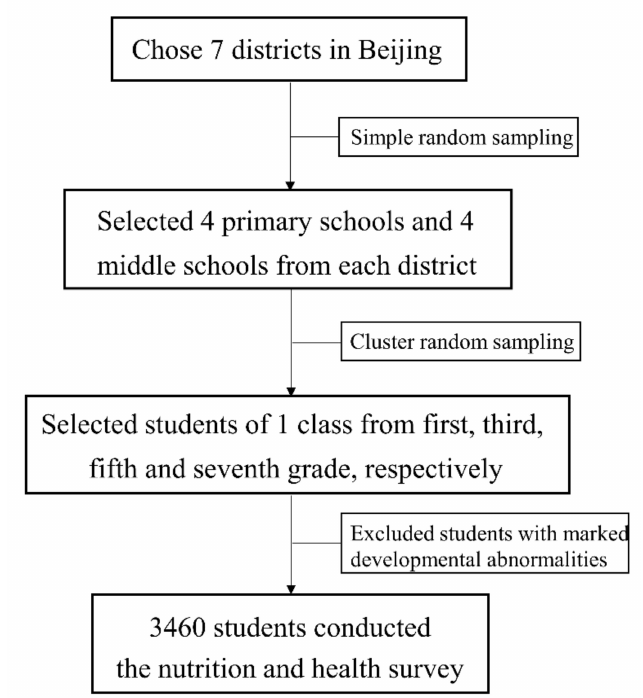
Figure 1. Flow diagram of the study